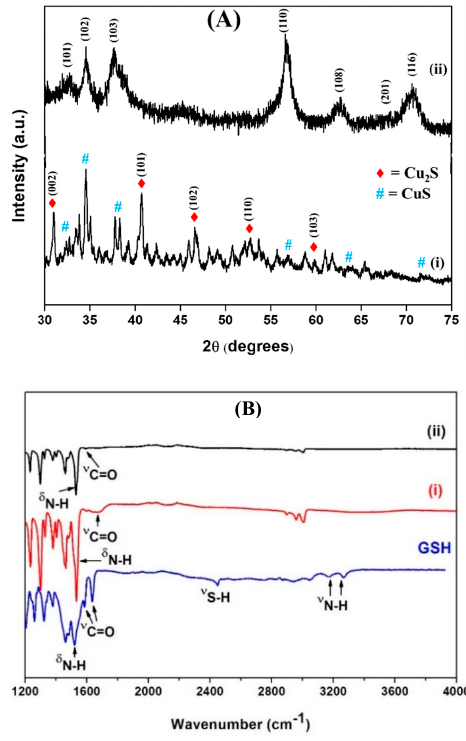
Figure 3. ( A ) XRD analysis of GSH-capped (i) CuS-1 and (ii) CuS-2. ( B ) FTIR spectra of GSH-capped (i) CuS-1 and (ii) CuS-2. 3.4. Electrochemical Characterization of the Cu x S y -Modified Screen-Printed Carbon Electrodes Cyclic voltammetry measurements of bare and Cu x S y -modified SPCE were carried out in a 1 mM K 3 [Fe(CN) 6 ]/K4[Fe(CN) 6 ] redox probe containing 1 M of KCl, at a potential window between − 0.2 and 1 V, at a fixed scan rate of 0.05 Vs − 1 . The Cu x S y nanoparticles prepared at different temperatures were assigned to CuS-1 and CuS-2, indicating nano- particles prepared at 50 °C and 95 °C, respectively, as shown in Figure 4. Cyclic voltam- mograms of the (i) bare SPCE and (ii) SPCE/CuS-1 and (iii) SPCE/CuS-2 showed typical redox peaks corresponding to the [Fe(CN) 6 ] 3 − /[Fe(CN) 6 ] 4 − probe (i.e., reversible Fe 3+ /Fe 2+ reduction and oxidation processes) at potential differences Δ E p (s) of 116 mV, 147 mV, and 674 mV, respectively. SPCE modified with CuS-2 showed a broad enhanced current peak at 0.682 V, which resulted from the presence of CuS nanomaterials on the surface of the SPCE. A similar peak was observed at 0.838 V for SPCE/CuS-1; these peaks are attributed to electrochemical oxidation of different crystal configuration and sizes of Cu x S y nano- materials present on the surface of SPCE. SPCE/CuS-2 further showed a high diffusion coefficient of 1.914 × 10 − 14 cm 2 s − 1 , as compared to 3.736 × 10 − 18 cm 2 s − 1 and 9.698 × 10 − 18 cm 2 s − 1 for SPCE/CuS-1 and bare SPCE, respectively. The diffusion coefficient (S1) [50] was calcu- lated to determine the rate at which electrons diffuse from the electrolyte solution to the electrode surface, and the results indicated that the CuS-1 conductive film allows fast elec- tron transfer of redox species from the bulk solution to the electrode’s surface.